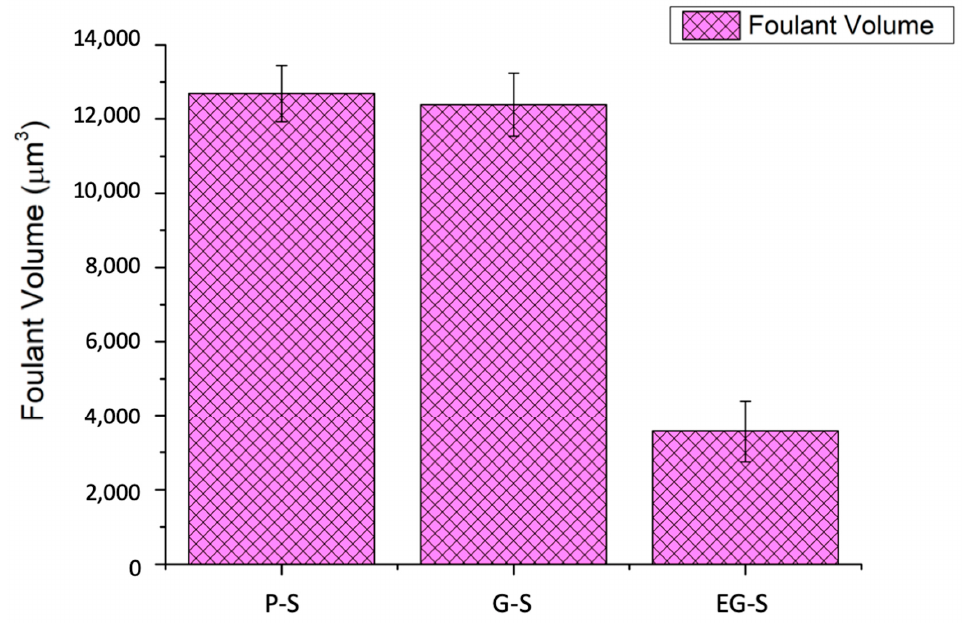
Figure 5. Average foulant volume for the fouled membranes with the P-S, G-S, and EG-S spacers.